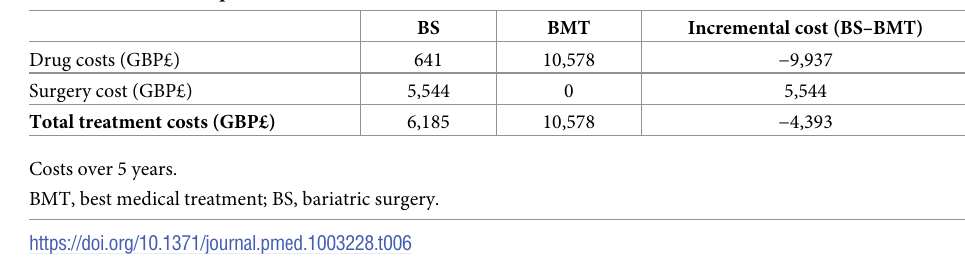
p -values test for linear trend derived from model where weight loss and excess weight loss were fitted as continuous variables. AGB, adjustable gastric band; CI, confidence interval; EWL, excess weight loss; RR, relative risk; RYGB, Roux-en-Y gastric bypass; SG, sleeve gastrectomy; WL, weight loss.